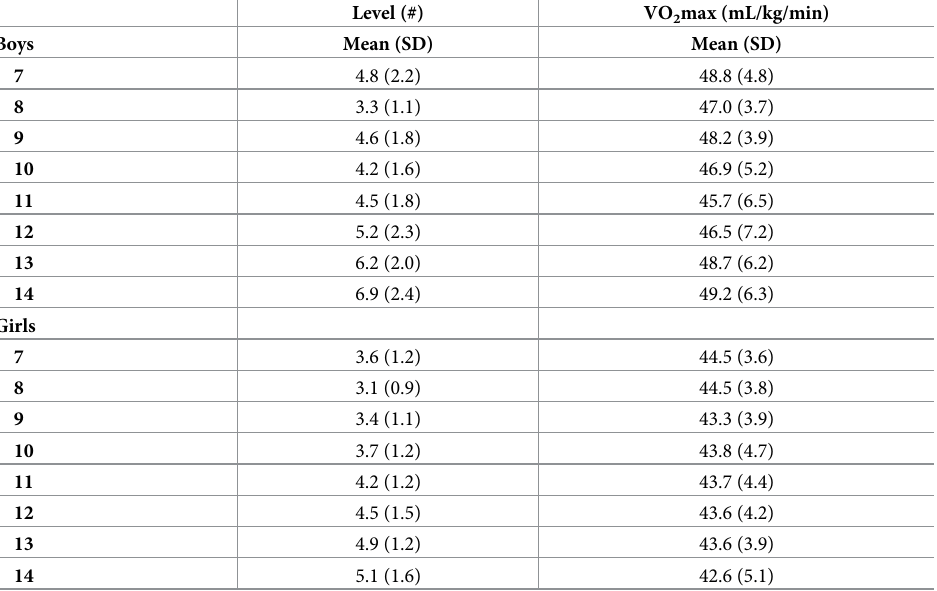
Table 2. Sex- and age- specific data for the maximal number of levels and the VO 2 max.